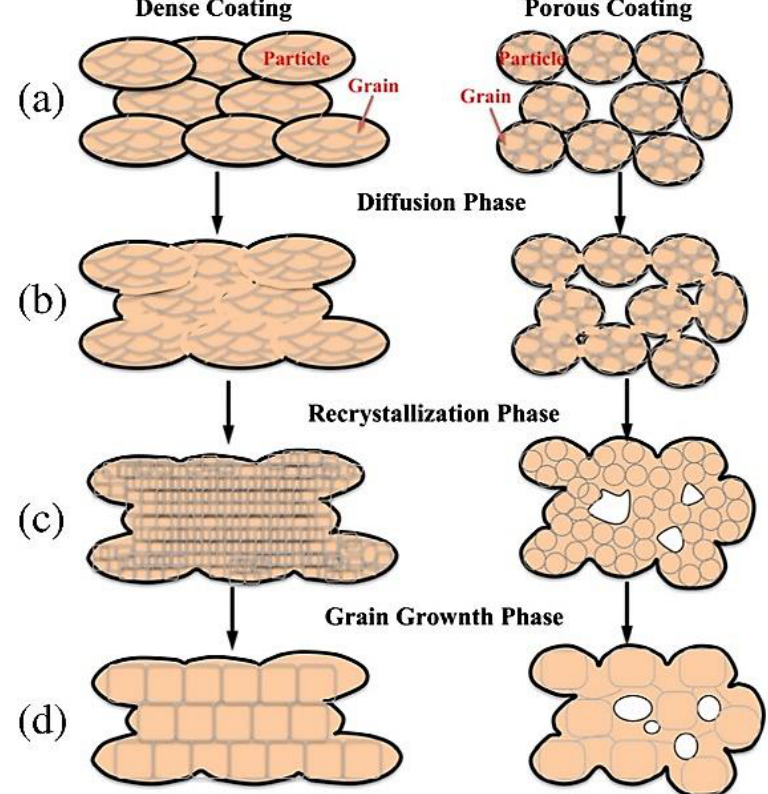
Figure 12. Schematic illustration of the CS deposit structure evolution during post-cold spray heat treatment. The evolution of CS densification is depicted by the ( a ) initial CS deposit, ( b ) the diffusion phase, ( c ) the recrystallization phase, and ( d ) the grain growth phase. Reprinted from Sun et al., Copyright 2020 [101], under CC BY 4.0.